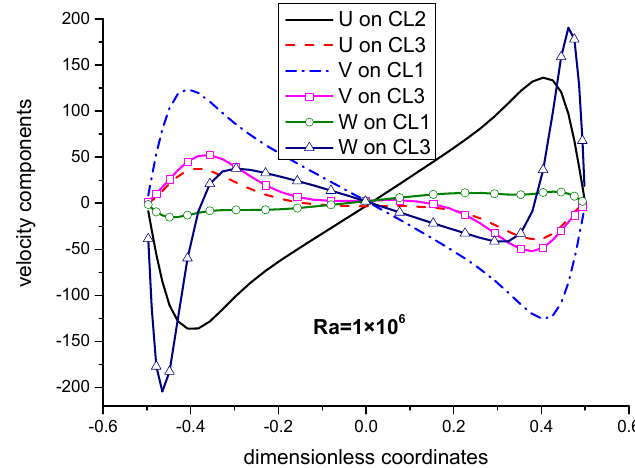
Figure 16. Velocity profiles on the center lines shown in Figure 14 for Case 4.